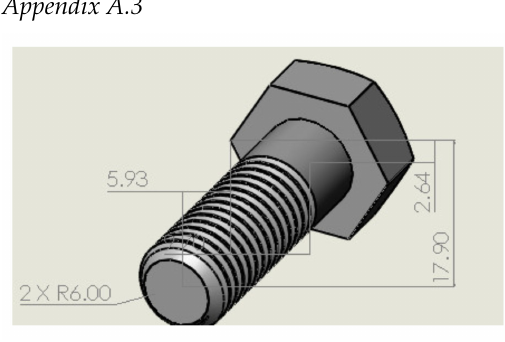
Figure A3. Bolt M12 (Dimensions in